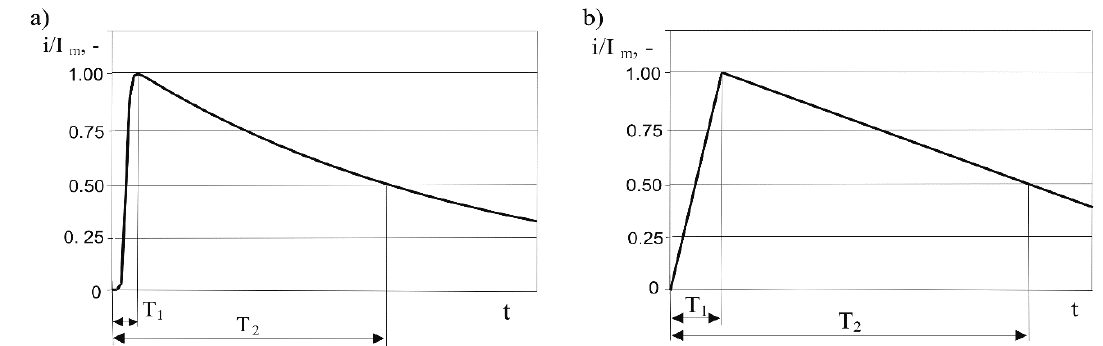
Figure 1. Models of lightning current: ( a ) Model of lightning current proposed by CIGRE [4,10,19], Heidler’s model of lightning current: T 1 = 10 μ s, T 2 = 350 μ s (for first negative and positive discharges), ( b ) T 1 = 0.1 μ s, T 2 = 25 μ s (for the successive negative discharges) [10,18].